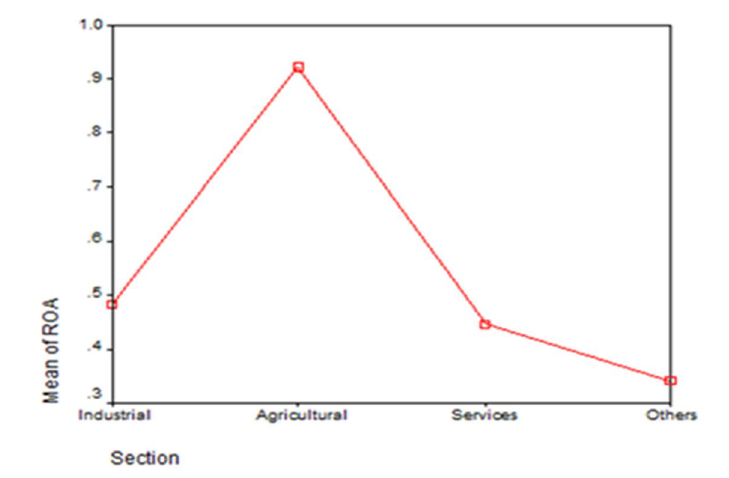
Figure 2- Comparing the ROA of different sectors at middle investment